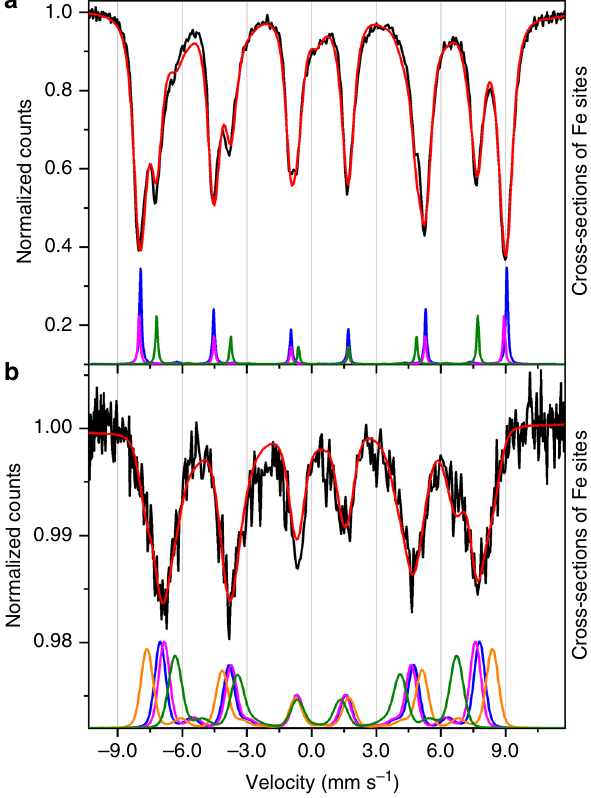
Fig. 3 Deconvolution of Mössbauer spectra in individual Fe 3+ contributions. a Mössbauer spectrum at 2.2 K of the dropcast sample (black line) and best fi t curve (red line); the cross-sections of the three inequivalent Fe 3+ sites expected in a twofold-symmetric molecule are shown in green, magenta, and blue and were calculated with the parameters listed in Table 1 (columns from left to right, respectively). b Mössbauer spectrum at 2.2 K of the monolayer sample (black line) and best fi t curve (red line); the cross- sections of the four inequivalent Fe 3+ sites (green, orange and blue/ magenta) were calculated with the parameters listed in Table 1 (columns from left to right,